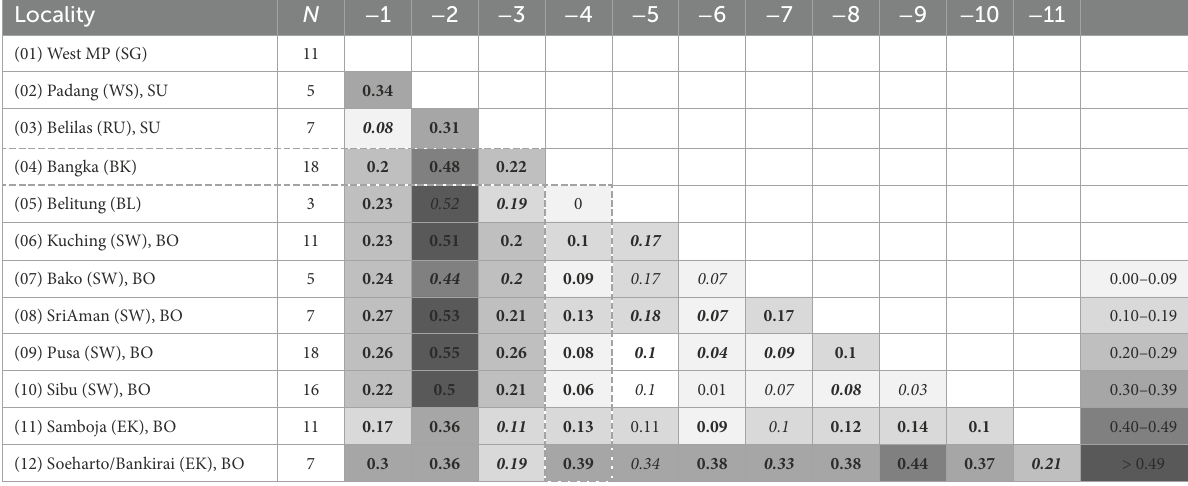
TABLE 2 Pairwise FST values for 12 populations of M. pruinosa based on ncSSR data. Locality